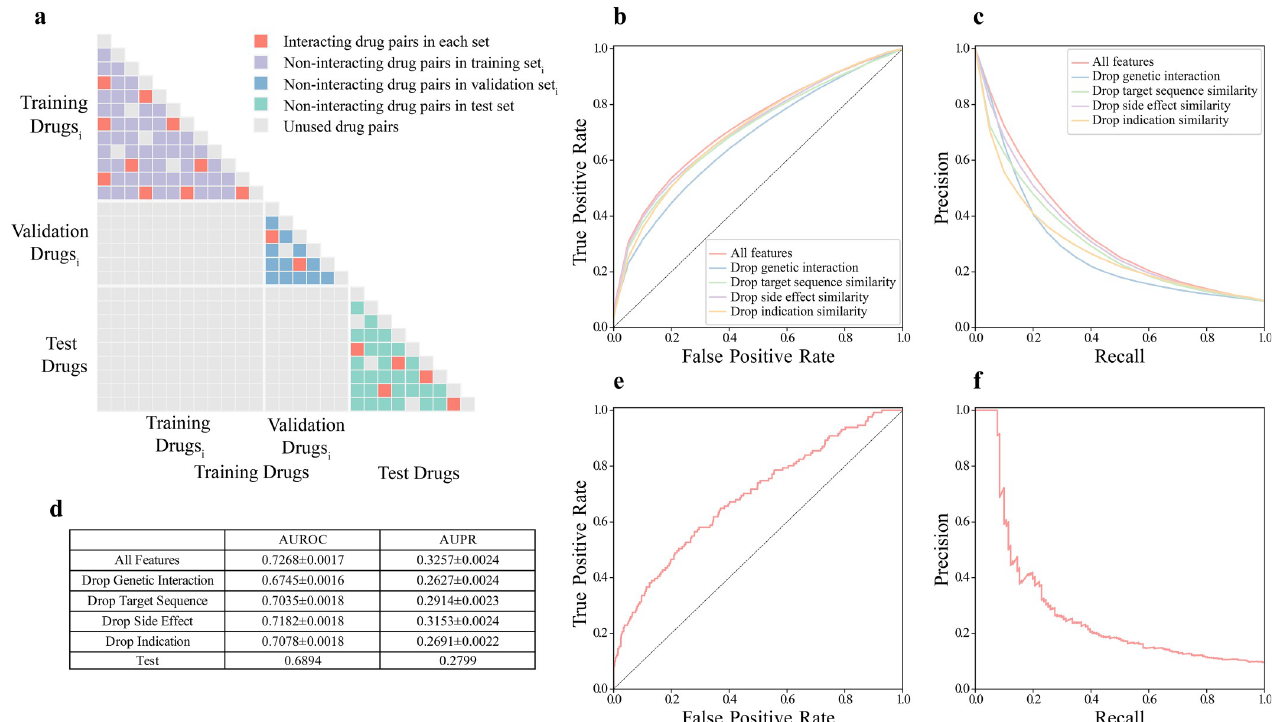
Fig 2. The train-test splitting scheme and model performance on the test set. (a) The train-test splitting scheme. Drugs are randomly divided into “training drugs” and “test drugs” with ratio of 2:1. Training set only consists of drug pairs constituted by “training drugs” and test set only consists of drug pairs constituted by “test drugs”. Training drugs are further split into “training drugs i ” and “validation drugs i ” with the same splitting scheme to obtain training set i and validation set i in the training phase. For each iteration of hold-out validation, the classifier is fit with training set i and evaluated with validation set i . Purple squares represent non-interacting drug pairs in training set i . Blue squares represent non-interacting drug pairs in validation set i . Green squares represent non- interacting drug pairs in test set. Red squares represent interacting drug pairs in each set. Grey squares represent unused drug pairs. (b) Approximate receiver operating characteristic (ROC) curves on the training set. (c) Approximate precision-recall curves on the training set. (d) AUROCs and AUPRs on the training set and the test set. (e) Receiver operating characteristic (ROC) curve on the test set. (f) Precision-recall curve on the test set.